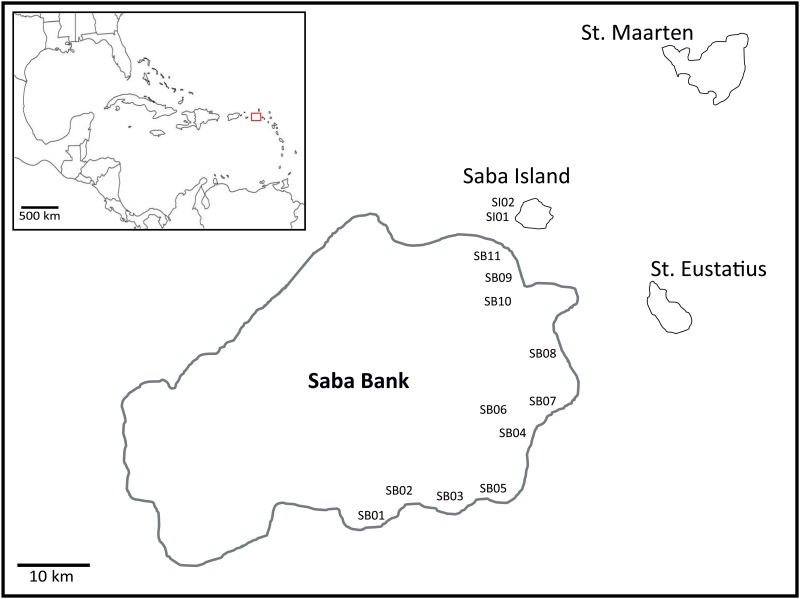
Sample locations on Saba Bank (SB01-SB11) and around Saba Island (SI01 and SI02).Included is a scheme of Saba Bank’s position with respect to nearby islands and in the wider Caribbean region (indicated by red square in overview).